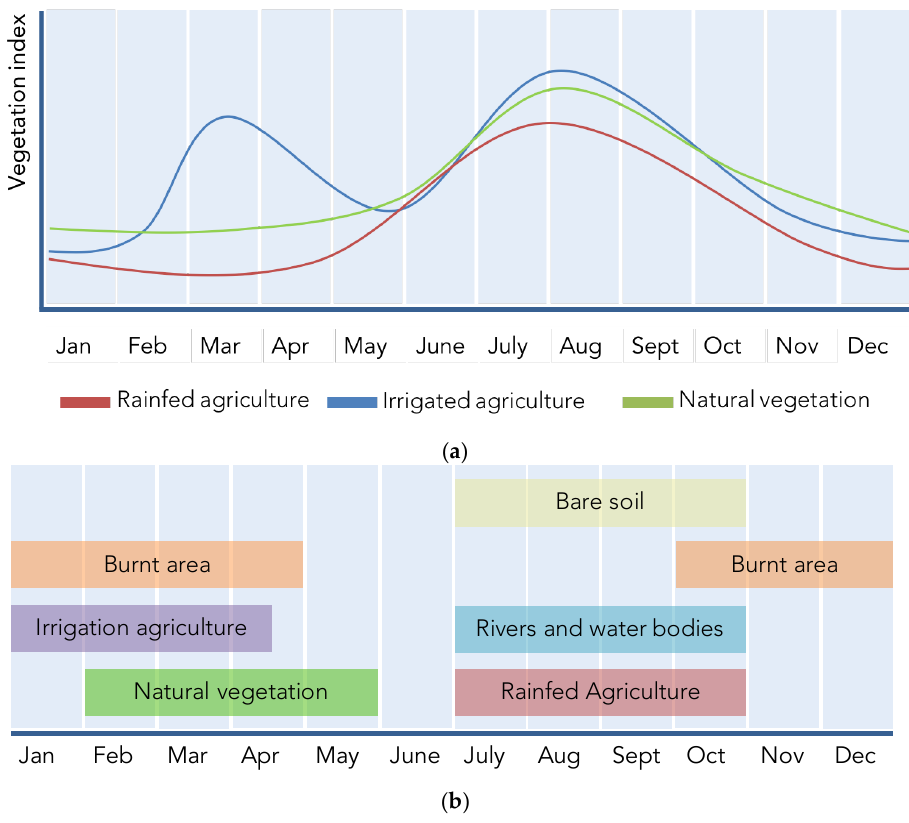
Figure 2. ( a ) Illustration of seasonal dynamics of vegetative activity for main land cover and land use classes. Adapted from temporal profiles at known locations for visualization purposes. ( b ) Temporal windows for each mapping components.